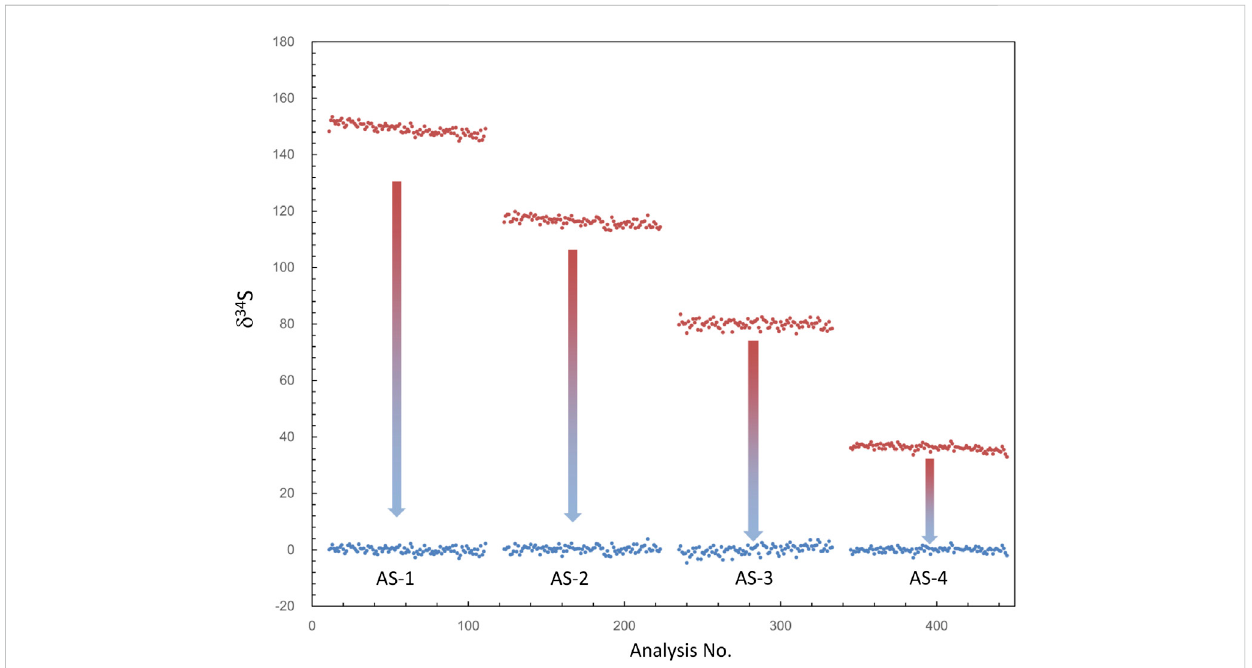
FIGURE 4 Theplotof δ 34 SofeachframemeasuredusingdifferentapertureslitsbeforeandafterQSAcorrection. δ 34 Sexp(beforethecorrection)isshowninthe redplot,and δ 34 Scor(afterthecorrection)isshownintheblueplot. δ 34 Sexppresentedatrendoflessinstrumentalmassfractionationwiththedecreaseof aperture slit width, leading to the decrease of the K value.